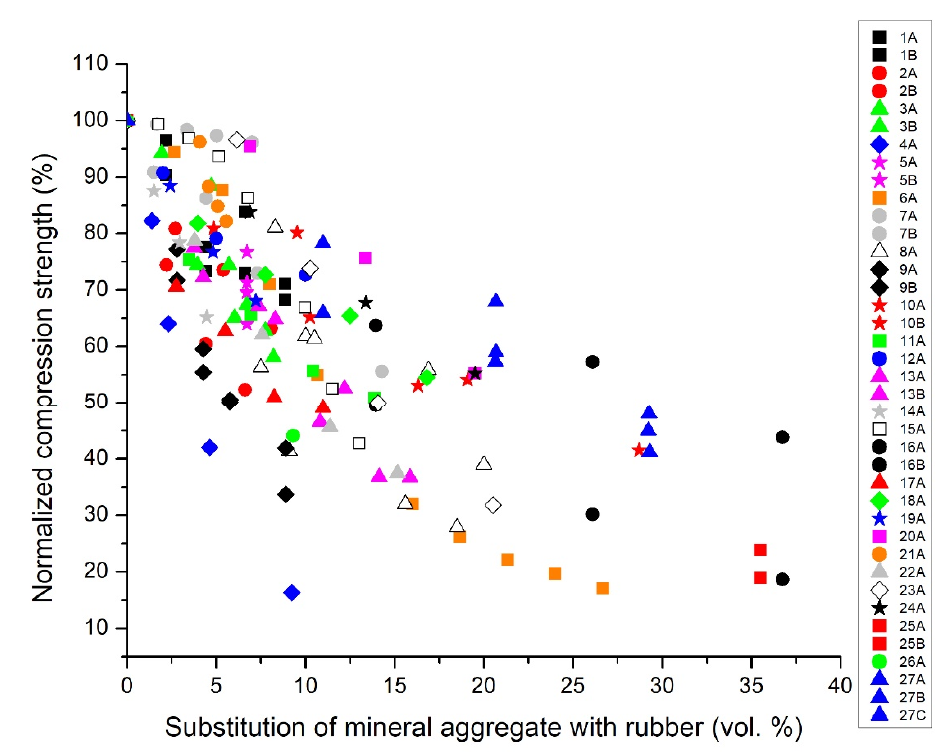
Figure 2. Reference diagram: normalized compression strength (expressed in %) vs. the volumetric percentage of substitution of the mineral aggregate with rubber (expressed in vol.%) recalculated using the fixed values of reference specific weight.